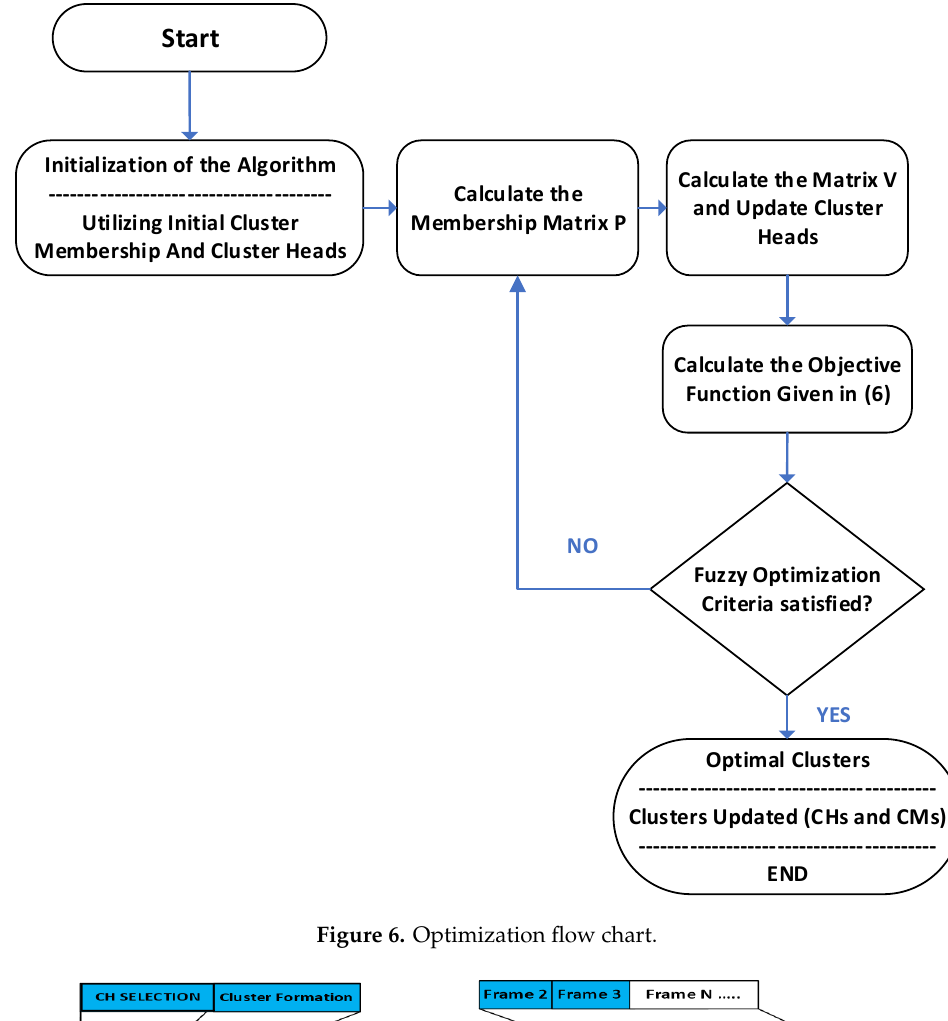
Table 2. List of Symbols. Symbol